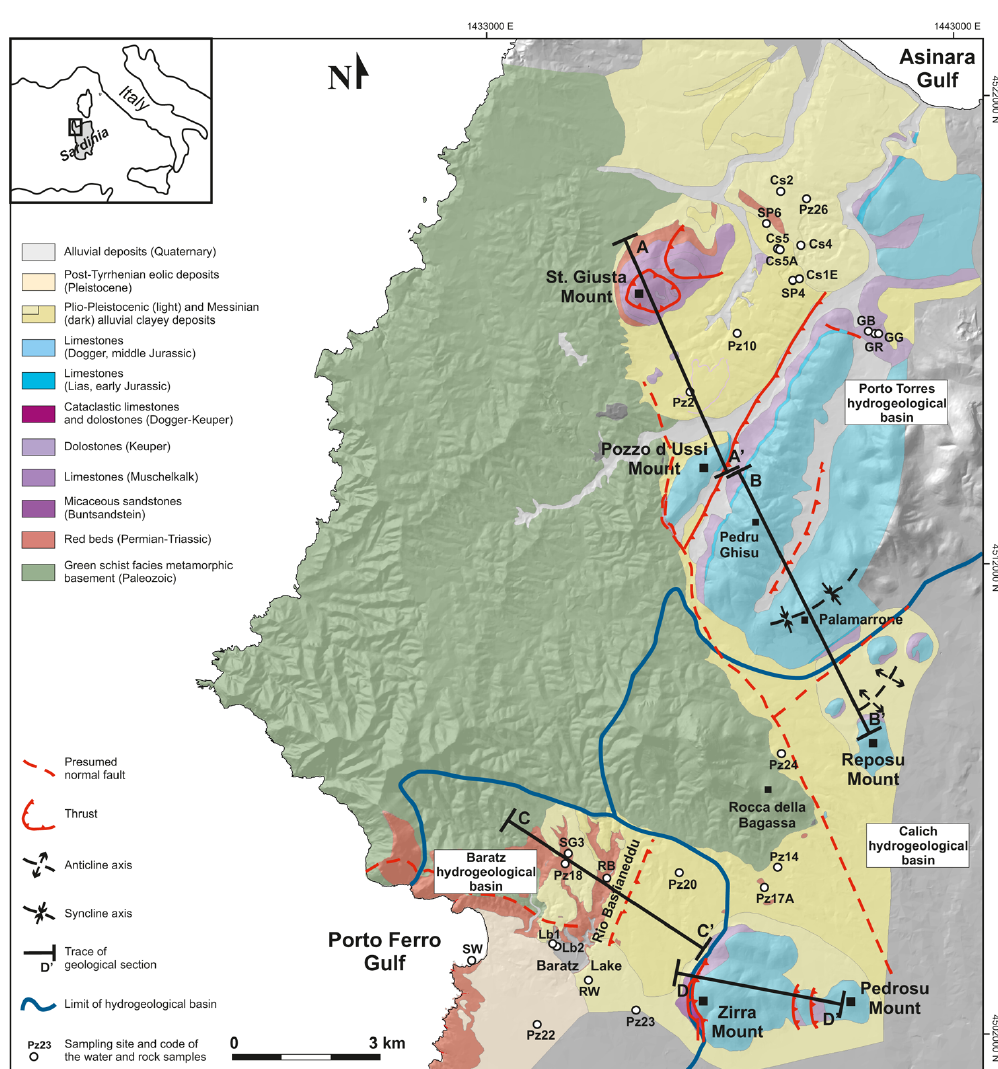
Fig. 1. Digital terrain model (DTM)-based geological map of investigated area. The localization of sampling sites and code of the analysed water and rock sample are shown. The limits of hydrogeological basins are from Ghiglieri et al. (2009). See text for further